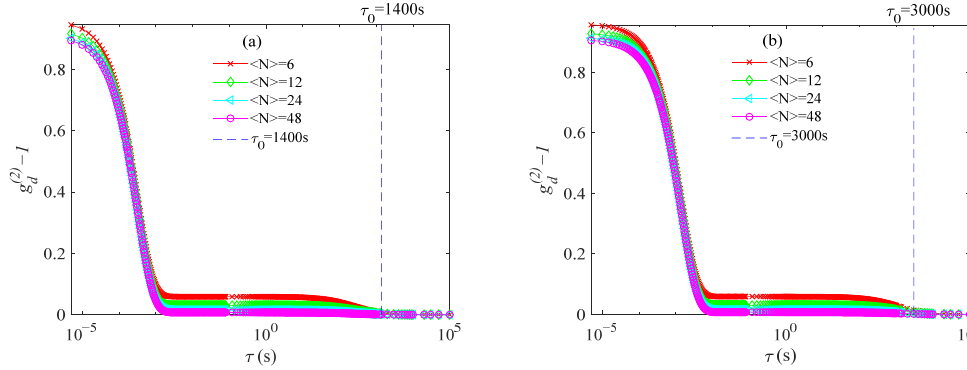
Figure 12. Simulated ACFs of particles for concentrations of < N > = 6, 12, 24, and 48: ( a ) 152 nm diameter and ( b ) 693 nm diameter.